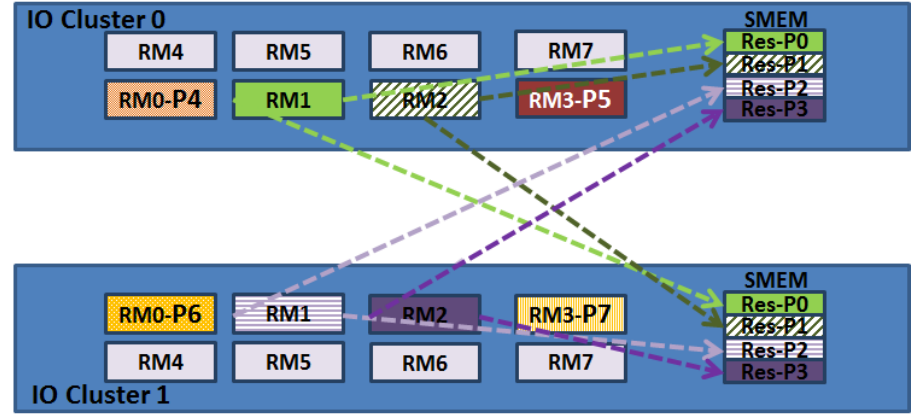
Figure 3. Proposed configuration for case-study (Part